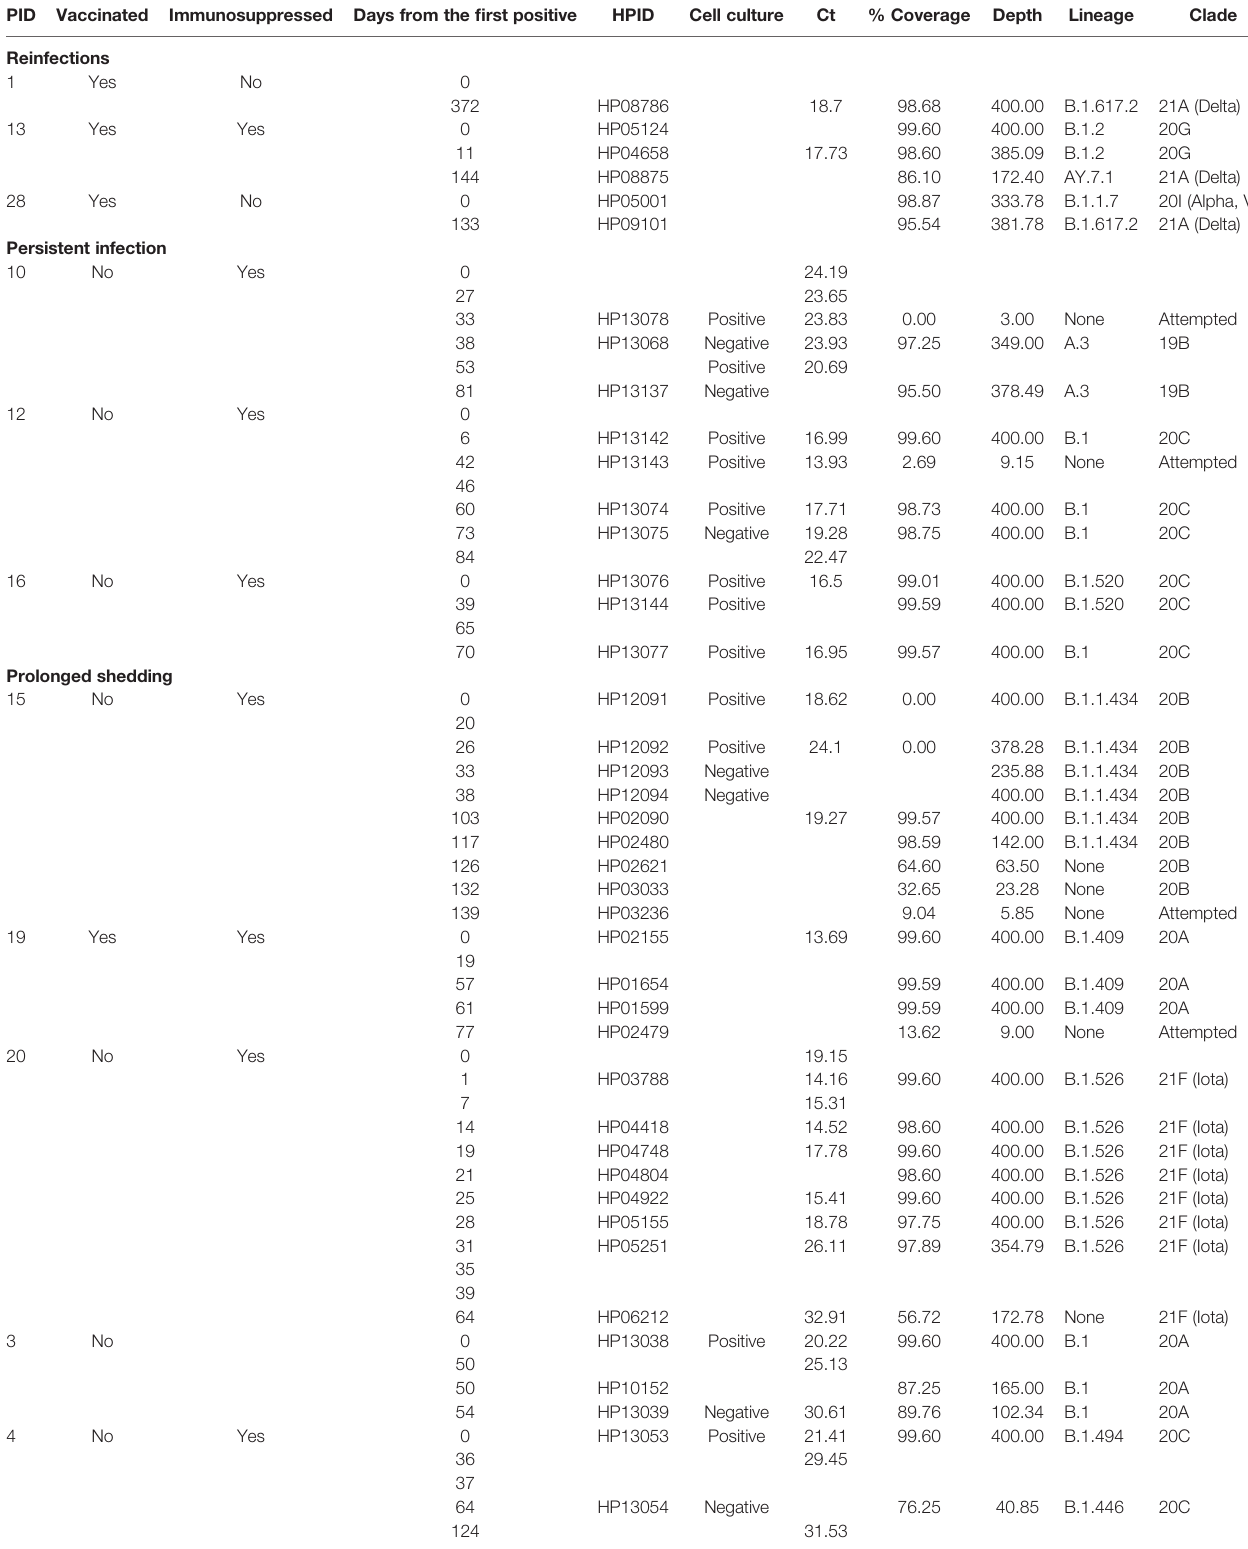
TABLE 2 | Prolonged shedding, persistent infections, versus reinfections. PID Vaccinated Immunosuppressed Days from the fi rst positive HPID Cell culture Ct % Coverage Depth Lineage